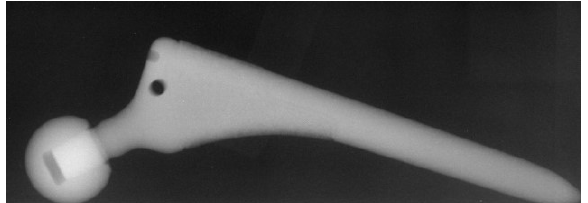
Fig. 3. Example of image of hip replacement, obtained with a moderated 14 MeV D-T source, image courtesy M. Taylor, Phoenix Lab, Madison, USA.